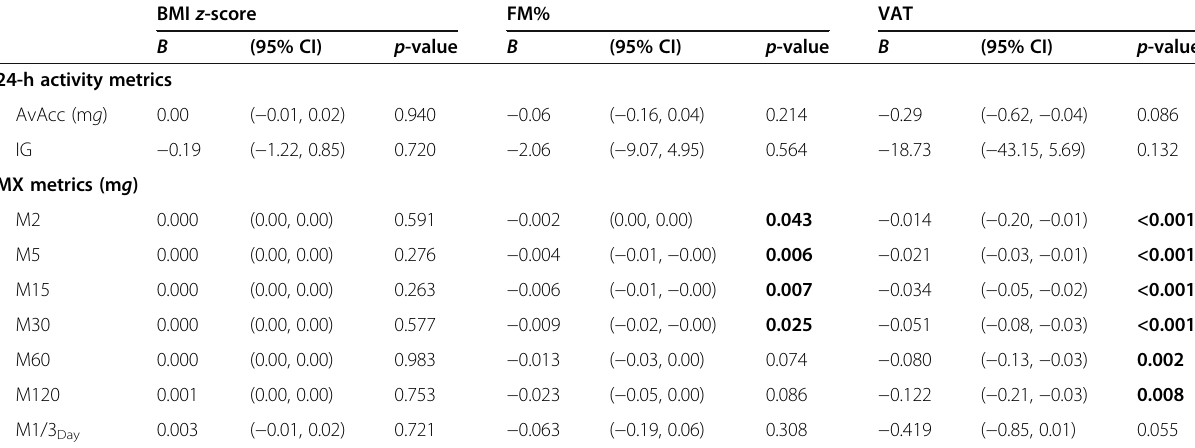
Table 2 Linear regression analysis of associations between 24-h activity metrics and adiposity indicators among children ( n = 382) BMI z -score FM%